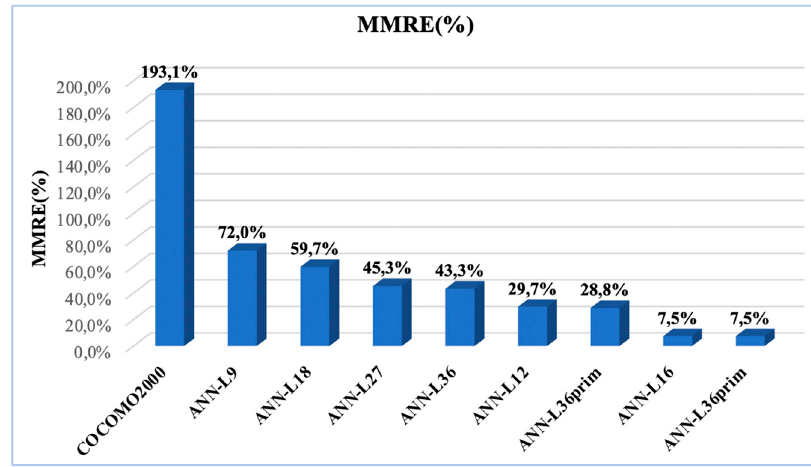
Figure 10. MMRE value for the approaches used. Table 13. COCOMO2000 and ANN vs. COSMIC FP and ANN vs. UCP and